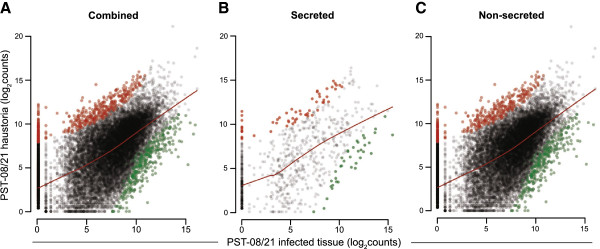
Comparison between infected tissue and isolated haustoria RNAseq libraries. Scatter plot of log2 transformed sequencing counts generated by aligning RNAseq reads to all PST-08/21 genes (A), those that encode predicted secreted peptides (B), or encode non-secreted peptides (C). Red and green colored circles correspond respectively to transcripts that were identified as significantly enriched or depleted in isolated haustoria as determined by DESeq analysis (P ≤ 0.01). Red lines represent the locally weighted polynomial regression (LOWESS method).